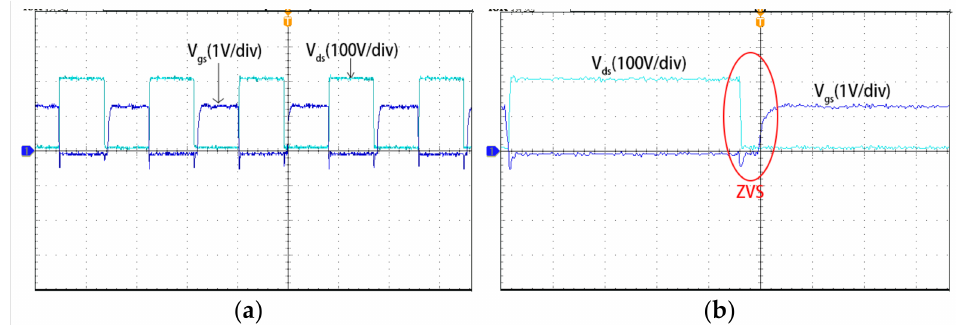
Figure 11. Experimental results for f s = 140 kHz: ( a ) Steady-state waveforms (time scale: 4 µ s/div);